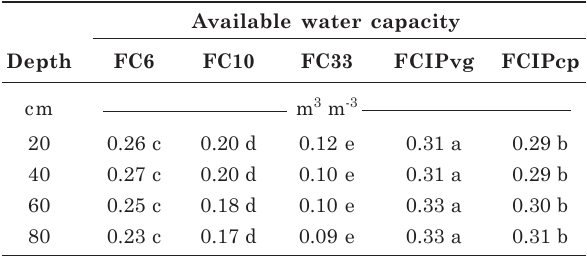
Table 6. Influence of the field capacity (FC) estimation method on the plant-available water capacity in an Oxisol